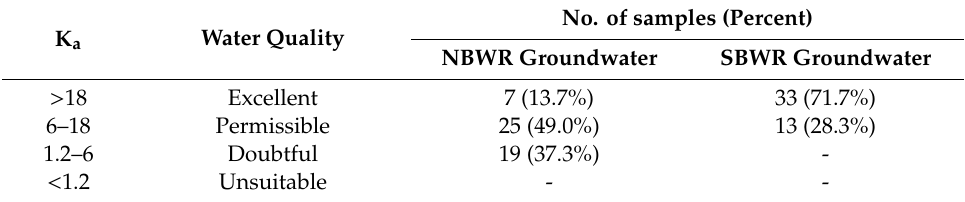
Table 7. The classifications of groundwater quality for irrigation based on the K a (the irrigation coe ffi cient) [30]. No. of samples (Percent) K a Water Quality NBWR Groundwater SBWR Groundwater > 18 Excellent 7 (13.7%) 33 (71.7%) 6–18 Permissible 25 (49.0%) 13 (28.3%) 1.2–6 Doubtful 19 (37.3%) - < 1.2 Unsuitable -